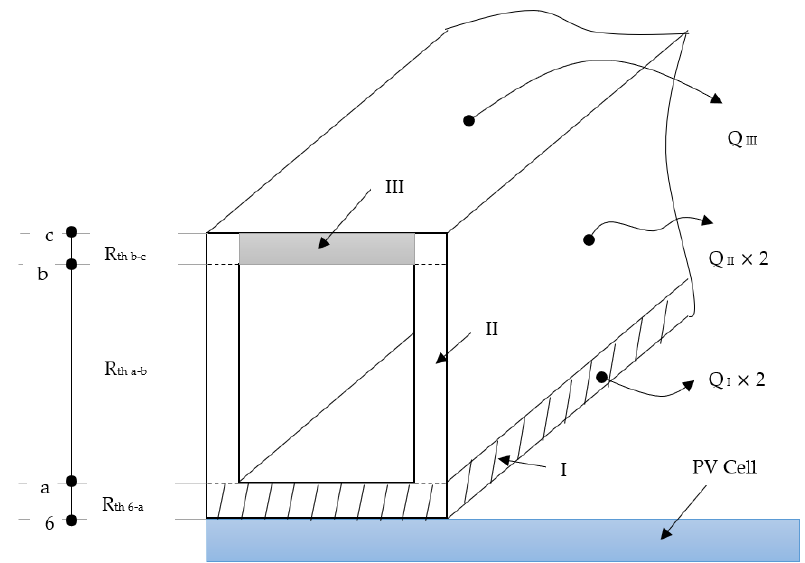
Figure 3. Components of heat lost from various surfaces of the pipe.